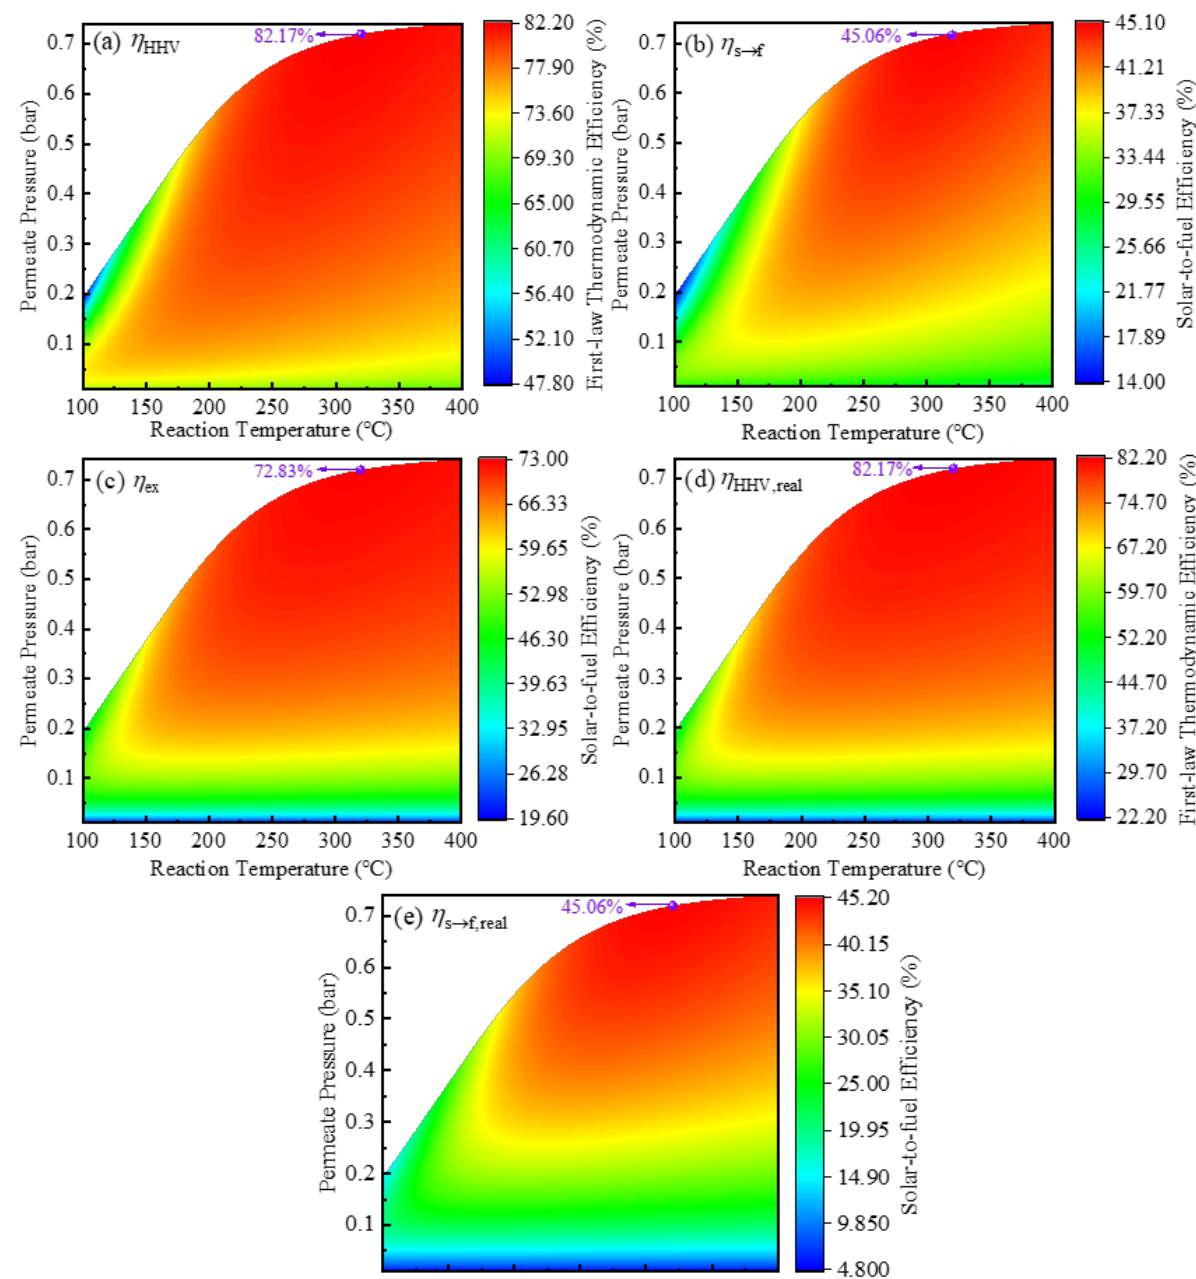
Figure 7. Thermodynamic efficiencies containing ( a ) η en , ( b ) η s → f , ( c ) η ex , ( d ) η en,real , and ( e ) η s → f,real versus temperature and permeate pressure. The maximum efficiency has been marked in the subfigures as purple points.